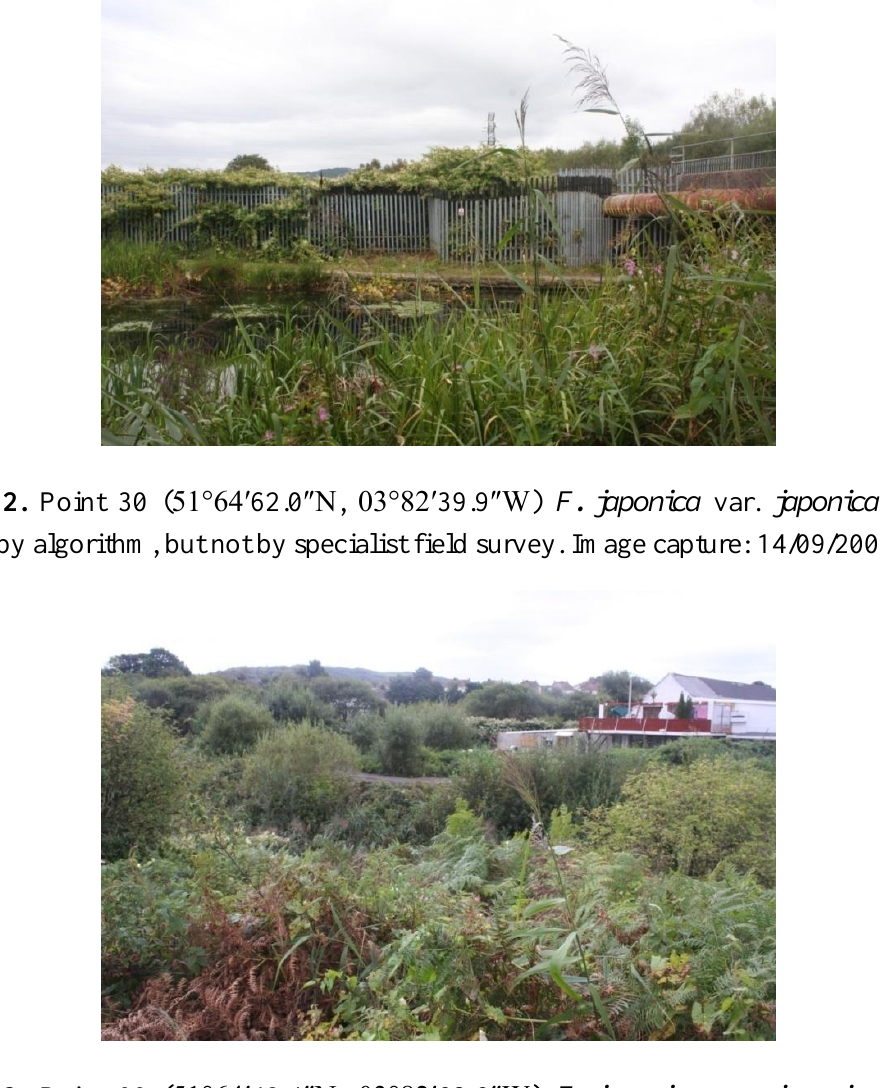
Figure 13. Point 90 (51°64′42.4″N, 03°82′68.6″W) F. japonica var. japonica stand(s) detected by algorithm, but not by specialist field survey. Image capture: